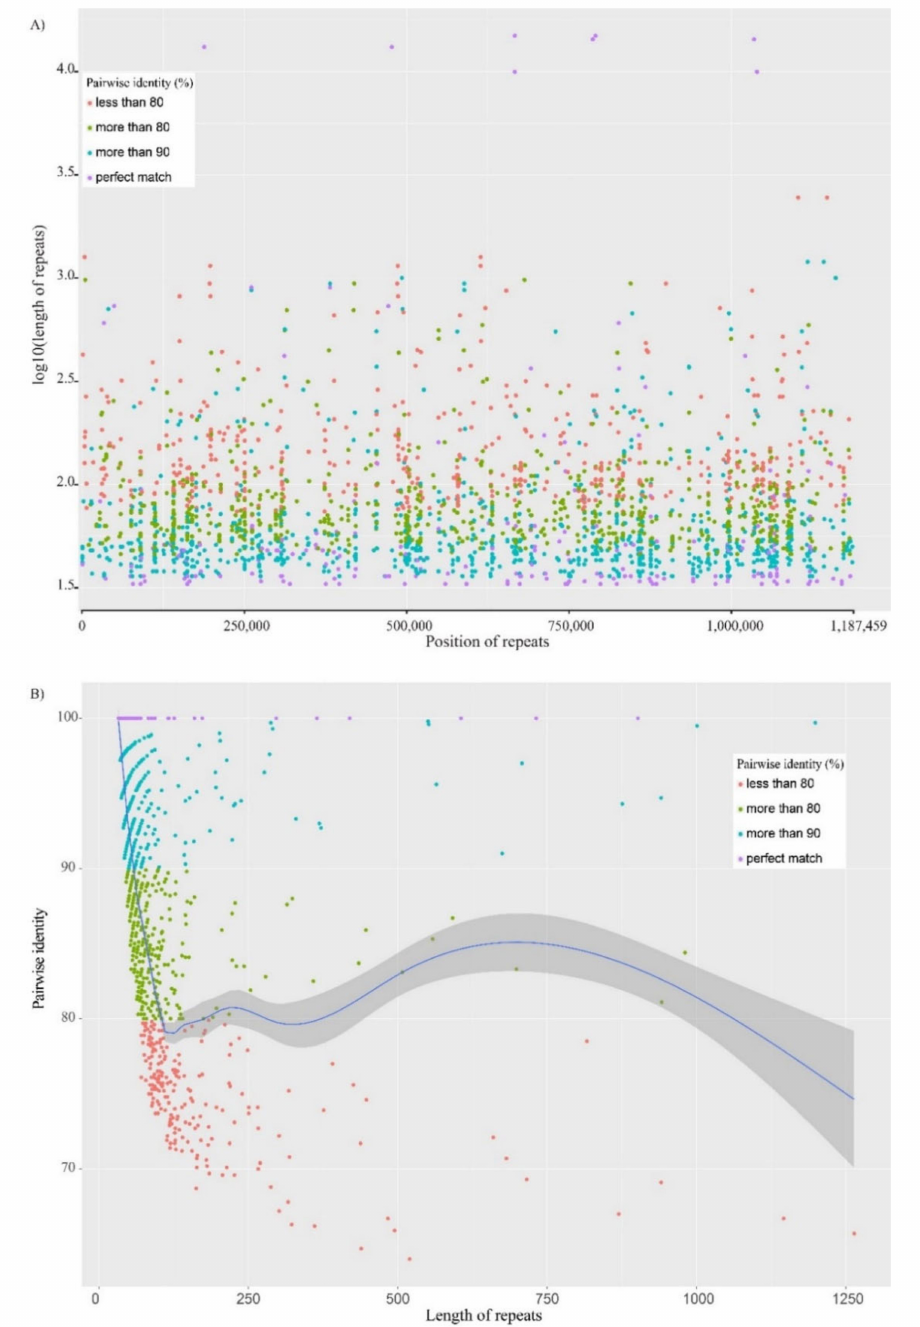
Figure 4. Dispersed repeats in the mitogenome of Valeriana sambucifolia f. dageletiana . Different- colored dots denote different percentage pairwise identities between dispersed repeats. ( A ) The length of repeats based on position. ( B ) Correlation between pairwise identity and the length of